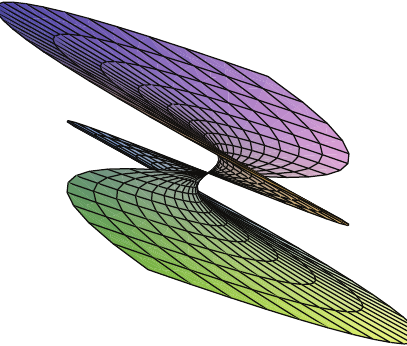
Figure 1: The surface of Enneper of the 2nd kind.